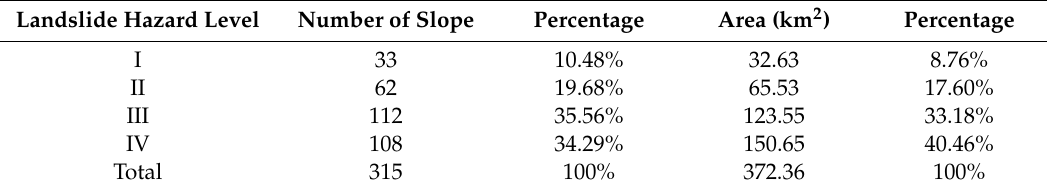
Figure 8. Final landslide hazard map for the study area. Table 6. Number and area of slopes of each hazard grade.